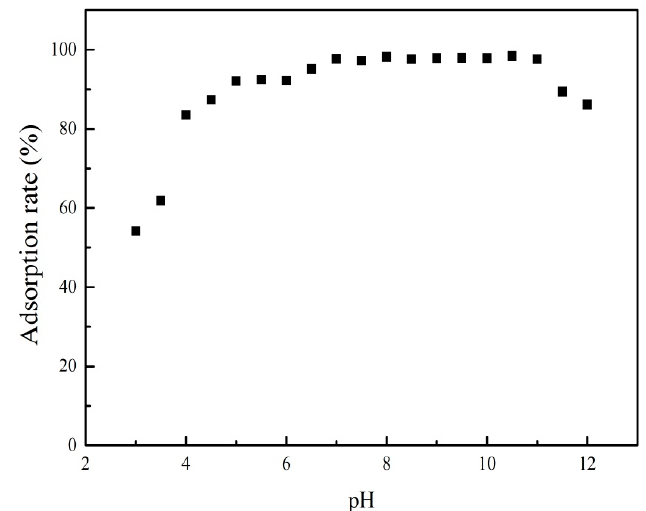
Figure 6. The effect of pH on the adsorption of PRO onto ATP/Fe 3 O 4 /GO.